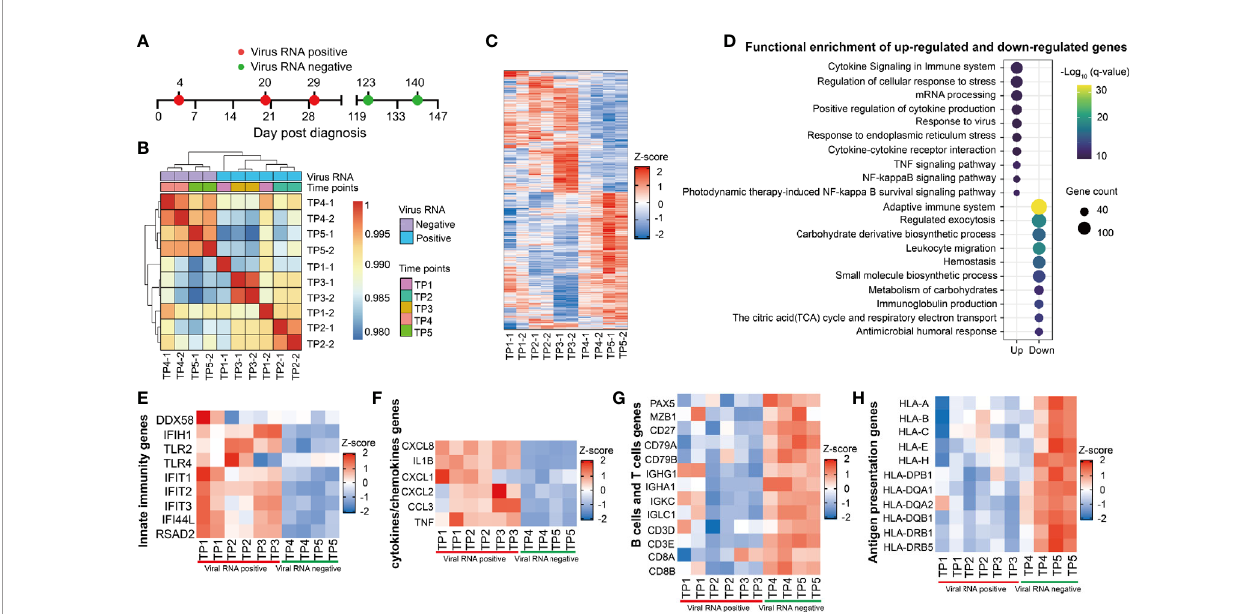
FIGURE 6 | Longitudinal transcriptional pro fi le of whole blood in the SARS-CoV-2 RNA re-tested positivity (RP) patient. (A) Samples of whole blood collected at fi ve different time points were used for RNA sequencing. (B) Heatmap of the correlation coef fi cient matrix across different time points. (C) Heatmap of the unique different expression genes (DEG) identi fi ed over time. (D) Functional enrichment analysis of up-regulated (top) or down-regulated gene (bottom) at TP1-TP3 comparing to TP4 and TP5. Color denotes statistical signi fi cance as measured by minus logarithm of p-values. (E – H) Heatmap of DEGs related to innate immunity response (E) , cytokines or chemokines (F) , B cells and T cells (G) , and antigen presentation (H) during viral positive and negative